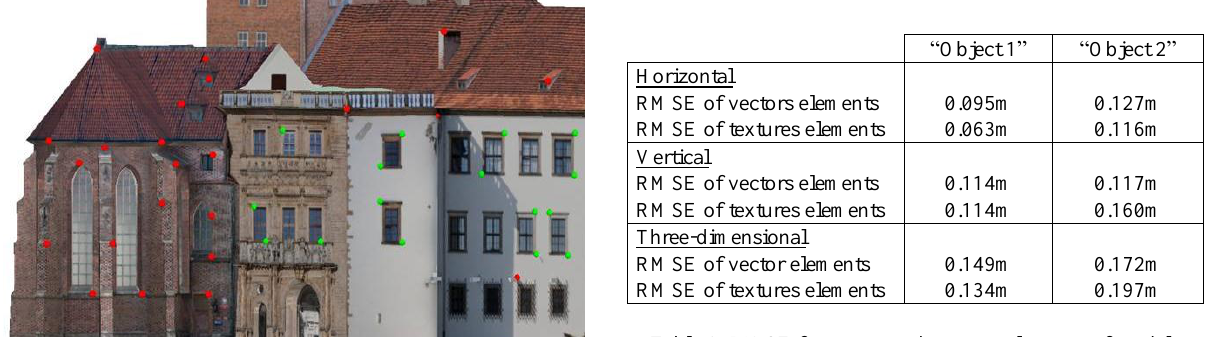
Table 3. RMSE for vector and textures elements of